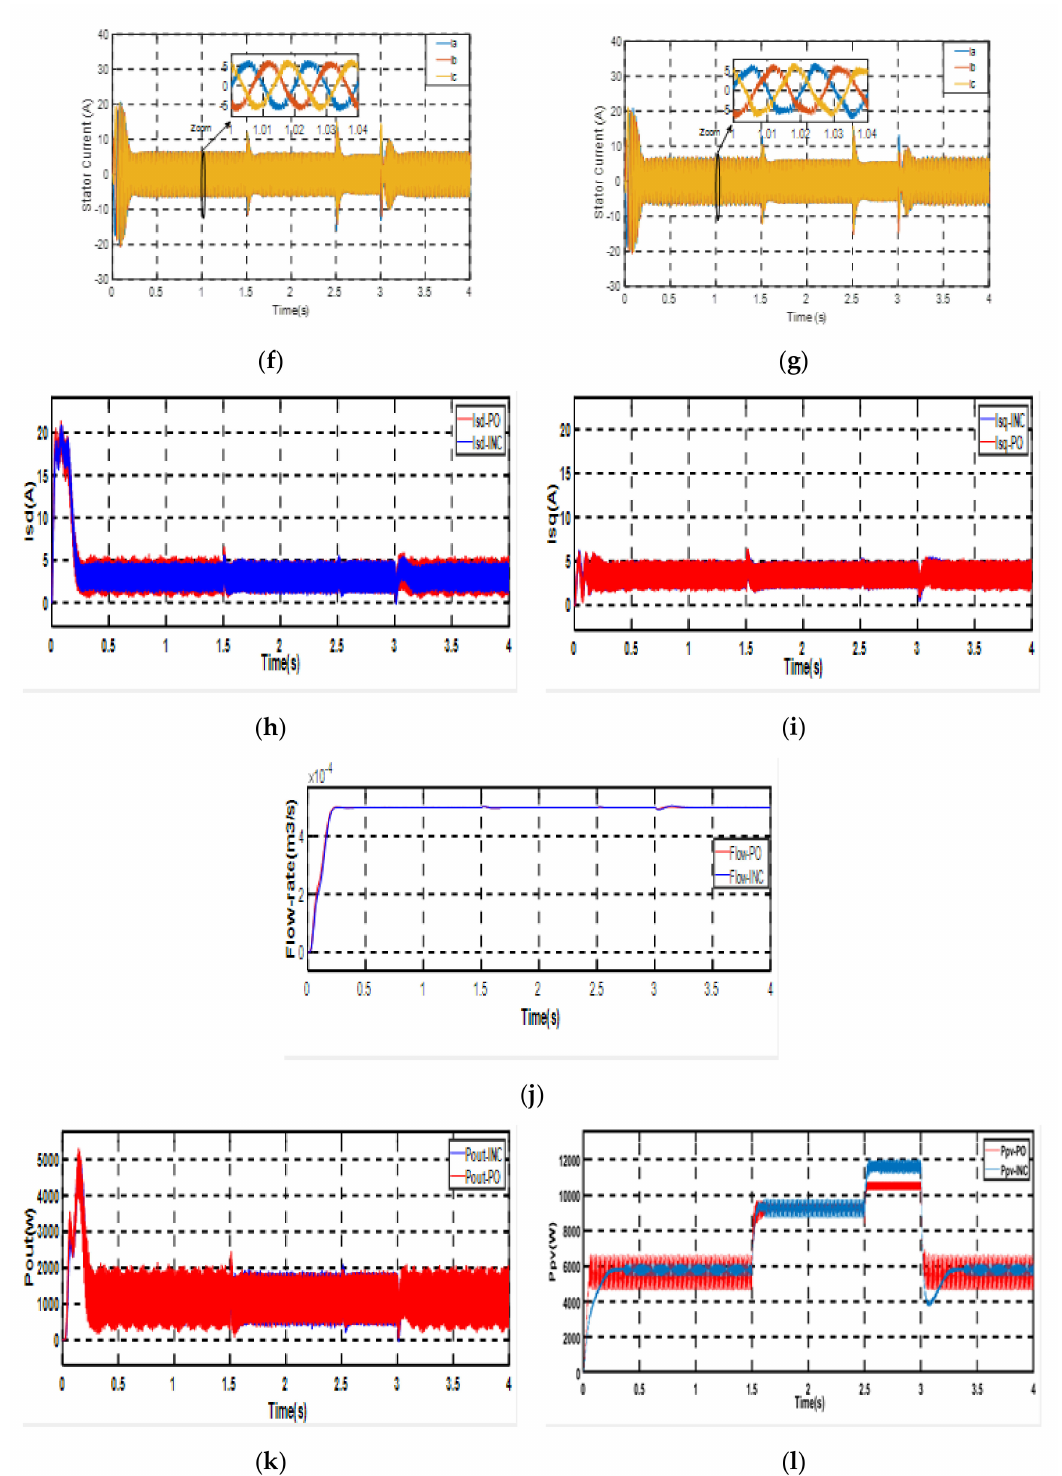
Figure 9. ( a ) Solar radiation. ( b ) Output voltage of the PV. ( c ) Output voltage of the boost converter. ( d ) Torque Evolution (N.m). ( e ) Mechanical Speed ( f ) Stator current—P&O. ( g ) Stator current—INC. ( h ) Current Isd. ( i ) Current Isq. ( j ) Flow pump evolution (m 3 /s). ( k ) Motor output power. ( l ) Output voltage of the